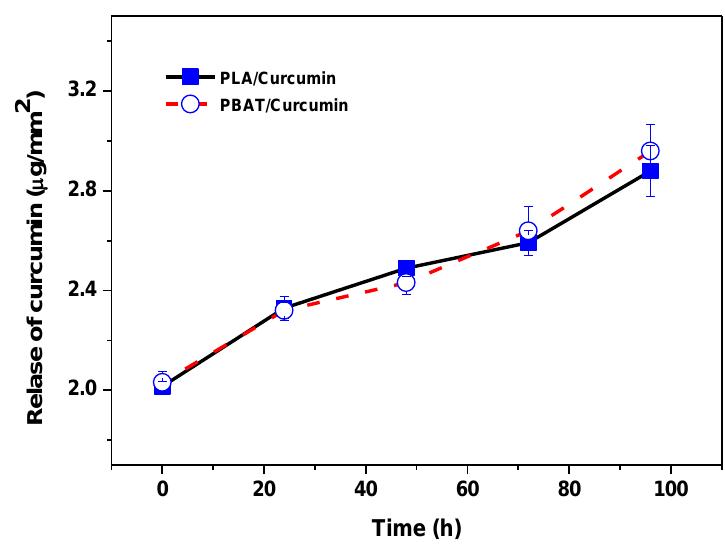
Figure 2. Release of curcumin from the bioplastic-based functional films.